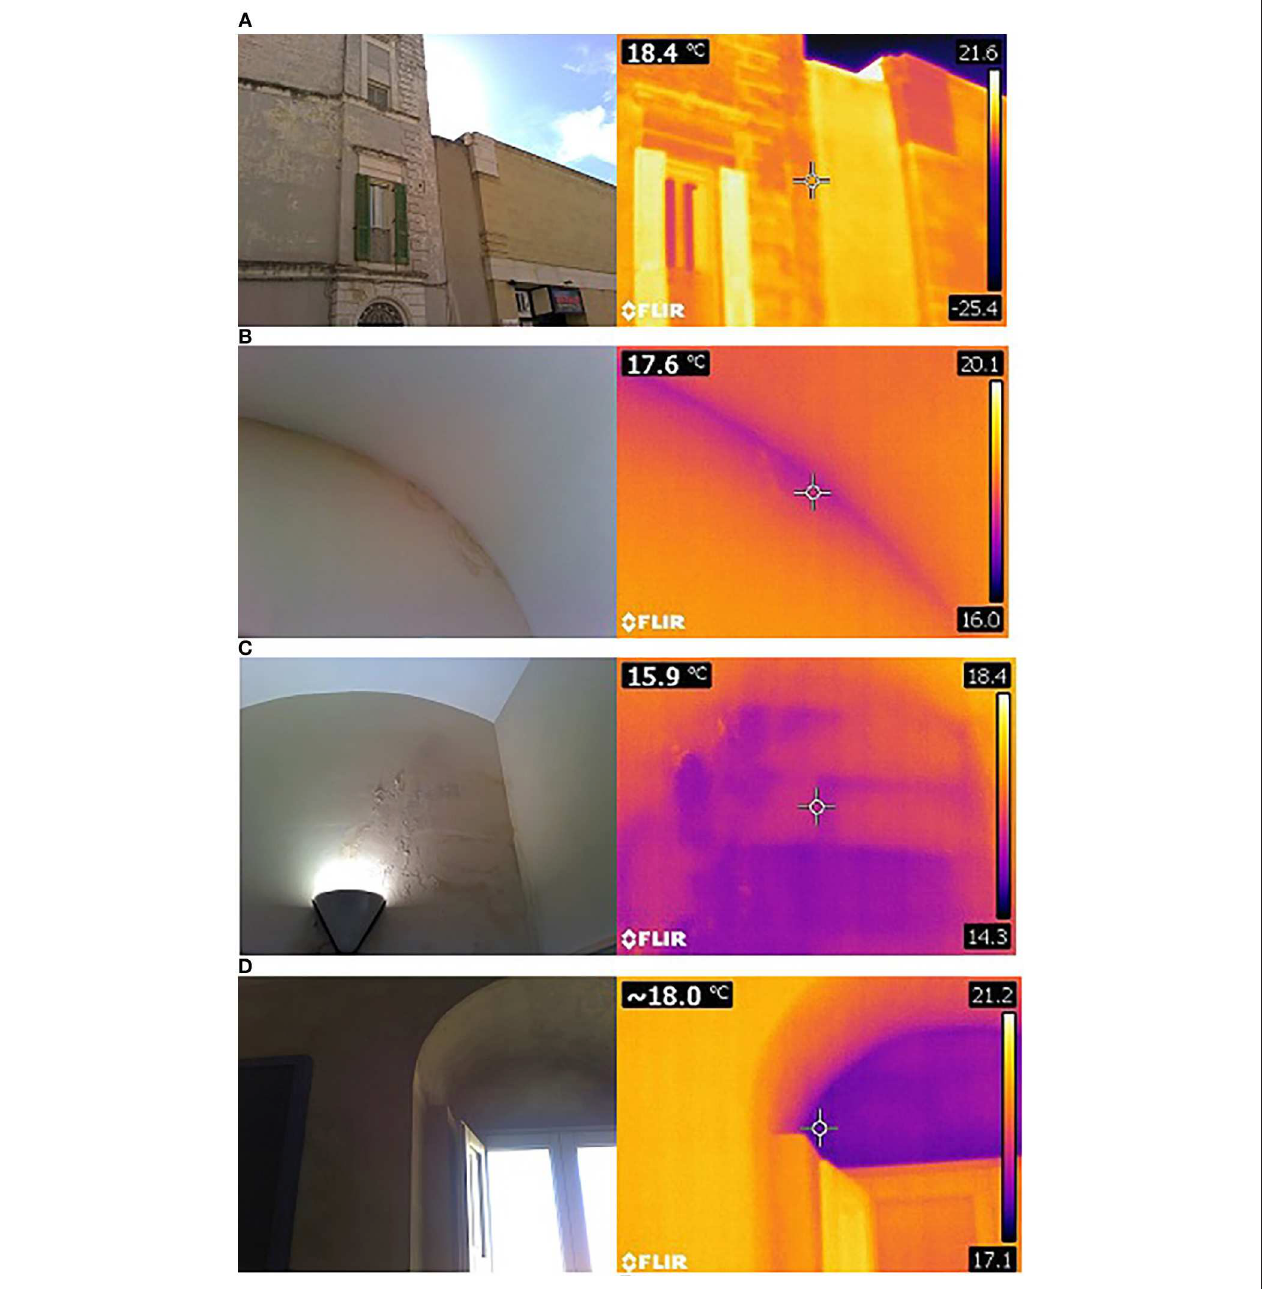
FIGURE 8 | (A) Thermography of new building, (B) Infiltration of water from the cover, (C) Infiltration of water from wall against earth, (D) Thermal bridge